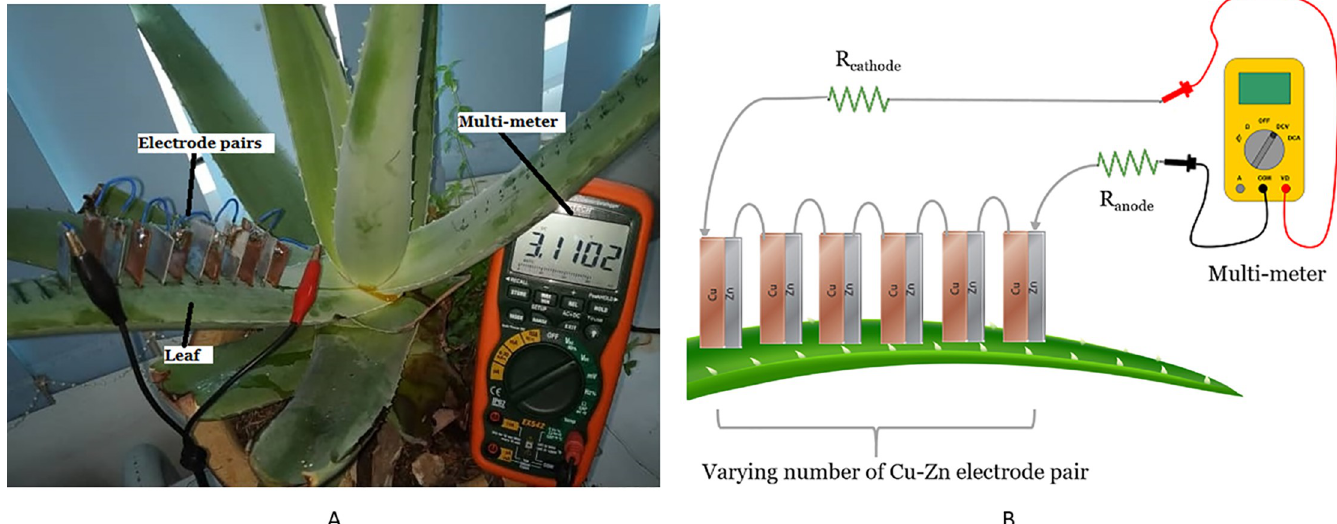
Fig 4. Experiment setup for a varying number of electrodes in a leaf. Example of setup arrangement (A) and simple schematic of the setup (B).